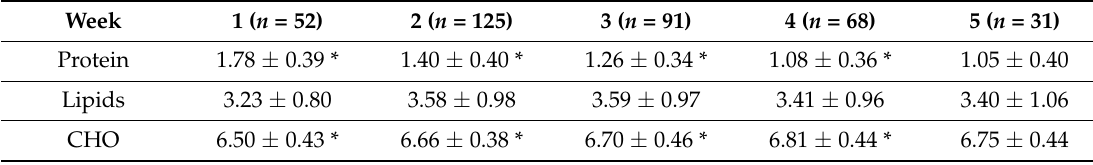
Table 2. Average milk composition per postnatal week.